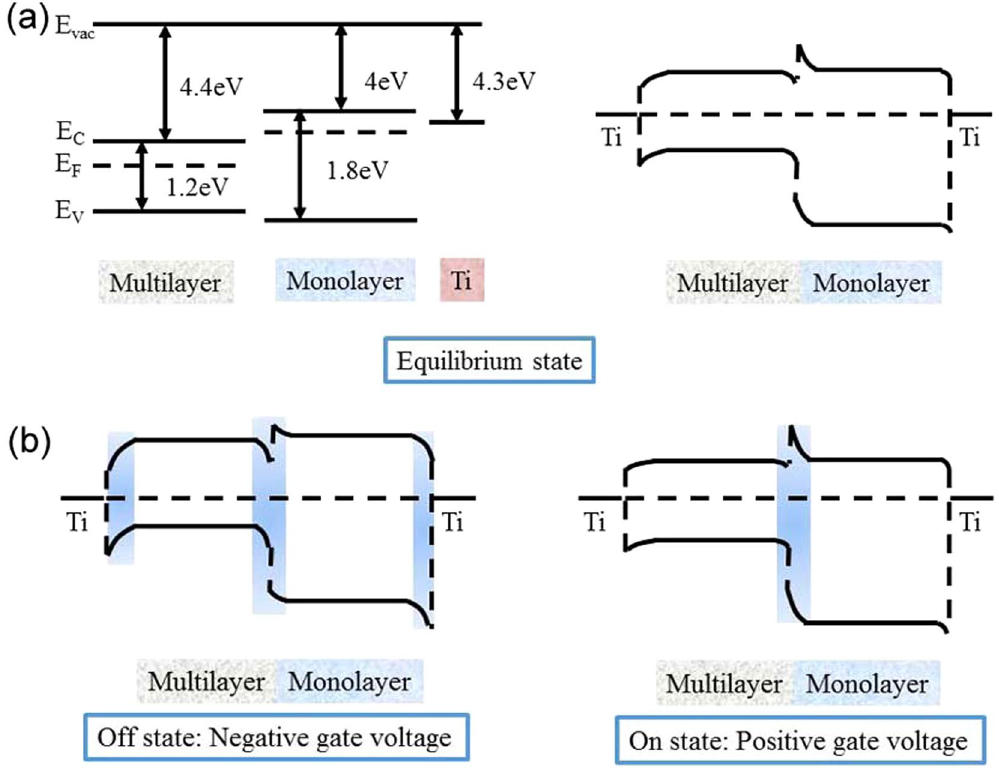
Figure 6. ( a ) The band diagram of the heterojunction in equilibrium state. ( b ) The band diagram of the heterojunction in off state (negative gate voltage) and on state (positive gate voltage) with the V ds = 0 V. The blue regions represent the effective photosensitive